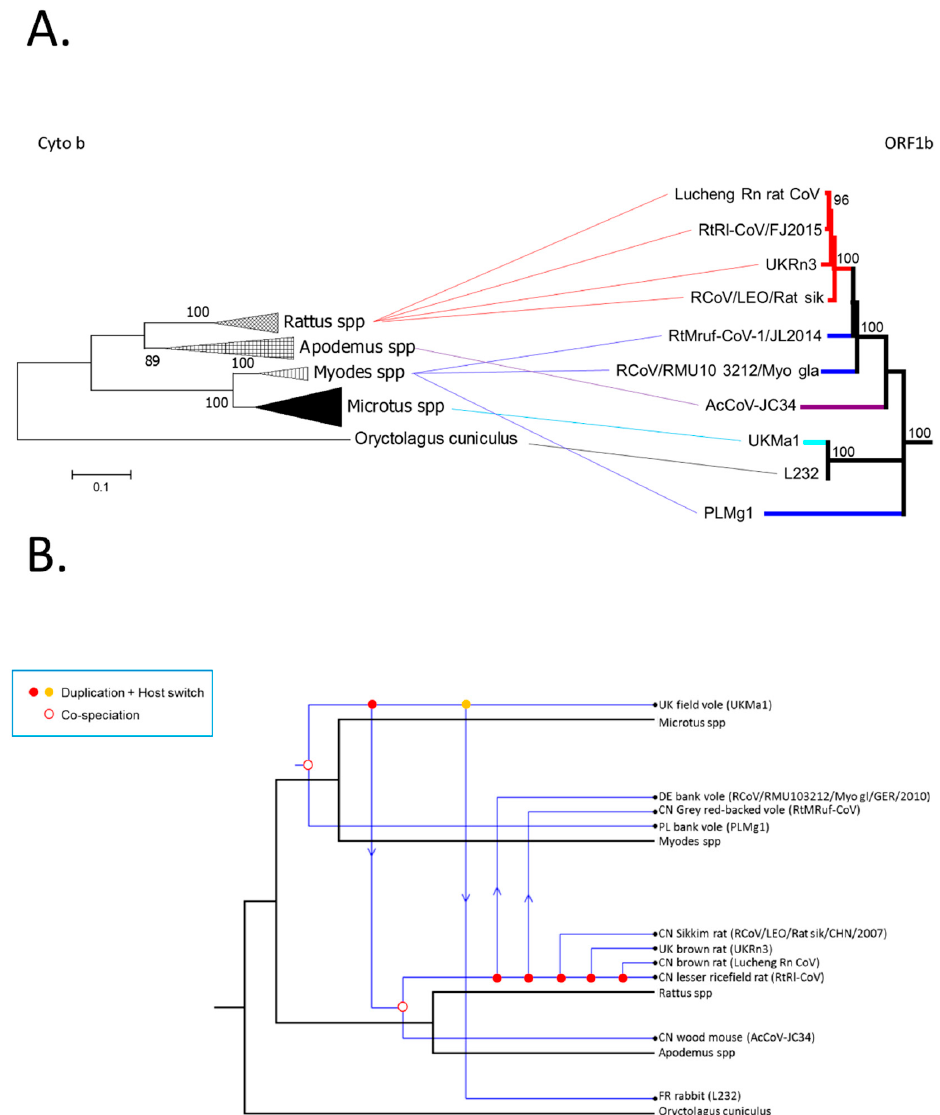
Figure 5. ( A ) Tanglegram of rodent cytochrome b and CoV ORF1b evolution. Maximum likelihood phylogenetic analysis of full-length rodent cytochrome b nucleotide sequences compared to rodent alpha-CoV ORF1b phylogeny. Cytochrome b sequences were obtained from GenBank for the rodent species Microtus , Myodes , Rattus , and Apodemus , and the rabbit Oryctolagus cuniculus , which was used as an outgroup. Branch lengths are drawn to scale: the bar indicates 0.1 nucleotide substitutions per site. Numbers above individual branches indicate the percentage that that branch was found in 1000 bootstrap replicates; only percentages >80 are shown. Blue indicates the Myodes spp., cyan the Microtus spp., purple the Apodemus spp., red Rattus spp., and black indicates Oryctolagus cuniculus . ( B ) Reconciliation of the sampled rodent alpha-CoV phylogeny with that of their mammalian hosts, utilizing the co-phylogenetic method implemented in the Jane package [16]. This figure shows the maximum possible co-divergence, duplication, and host switching